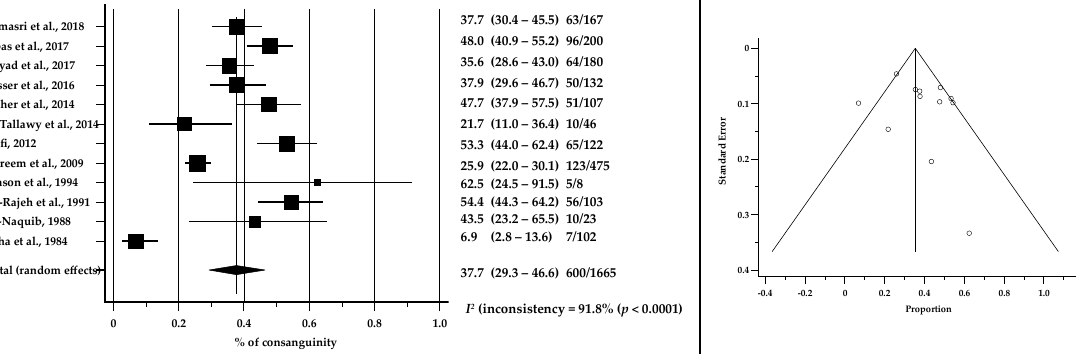
Figure 5. Forest plot (to the left) shows the pooled estimates % of consanguinity among children and adolescents with CP in ASCs [35,36,38,40,43,46–50,55,60]. Assessment of publication bias by Funnel plot (to the right) shows individual study estimates against corresponding standard errors (Kendall’s Tau = 0.09091, p = 0.6808). I 2 suggests considerable heterogeneity between